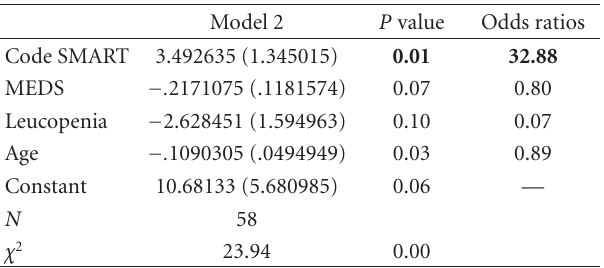
Table 6: Model 2—Logistic regression of mortality controlling for + / − use of Code SMART, MEDS, leucopenia, and